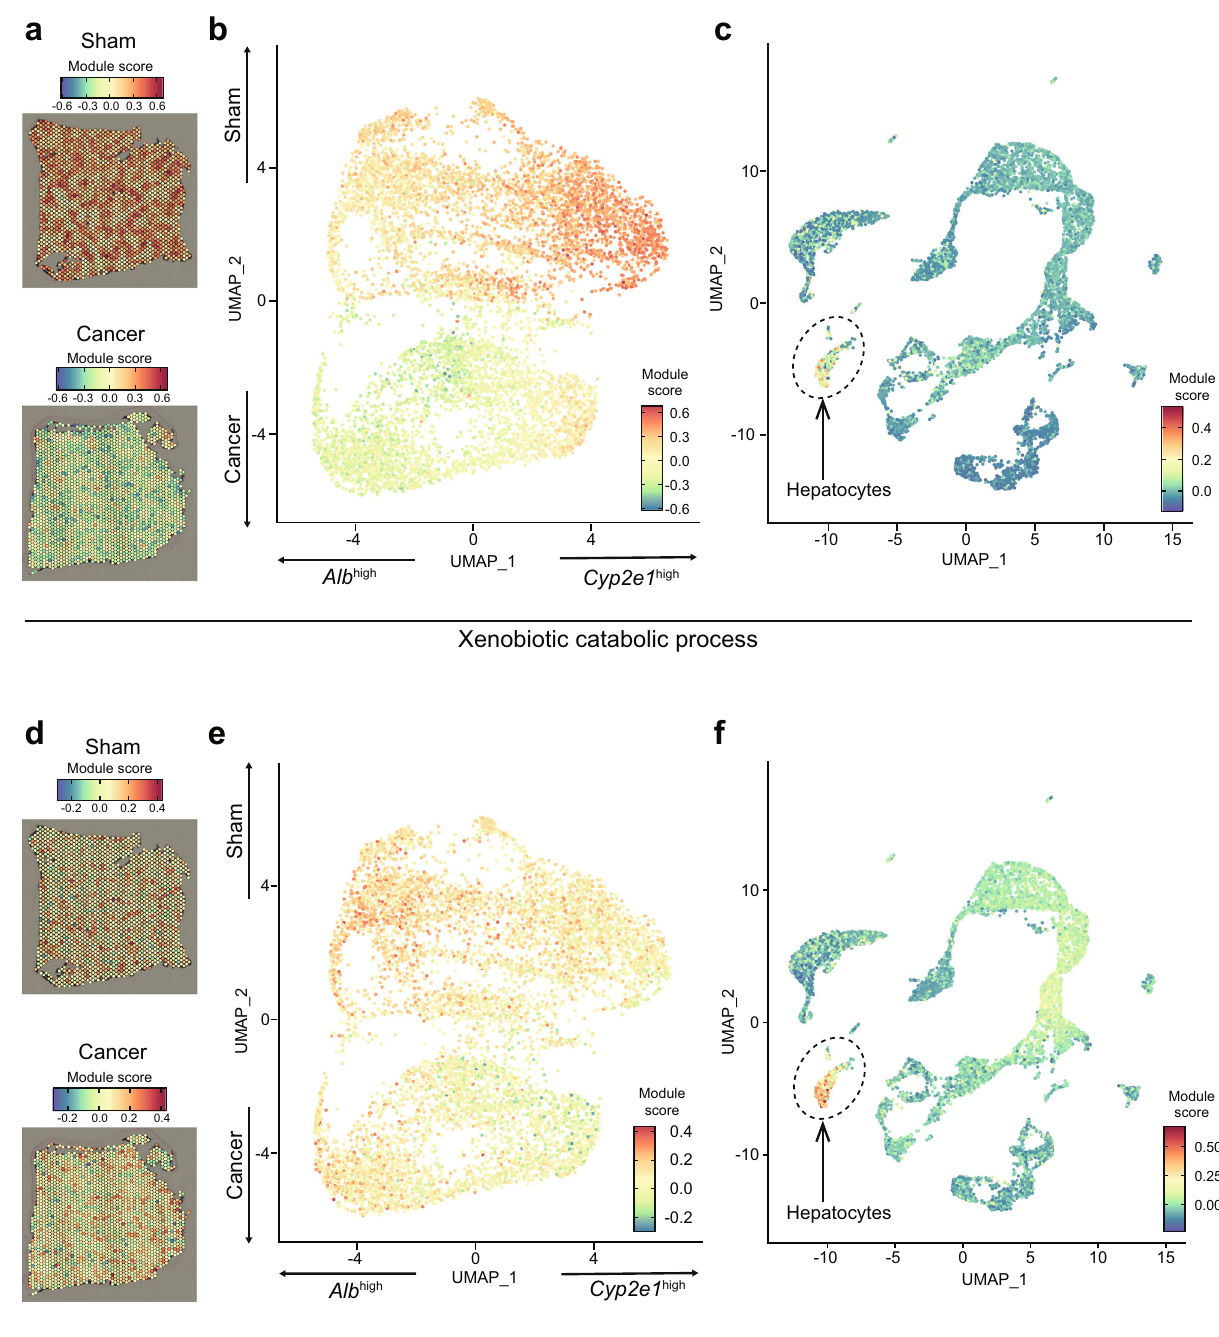
Fig. 3 4T1 breast cancers disrupt liver zonation in various manners. a – c For the genes associated with the GO term “ xenobiotic catabolic process ” . a Module scoresinoneoftheshamandcancerVisiumsamples. b ThesamemodulescoresinaUMAPrepresentationoftheVisiumdata. c ModulescoresinthescRNA-seqdata, showing high scores predominantly in the hepatocyte cluster. d – f Same as a – c for genes associated with the “ aspartate family amino acid metabolic process ” GO